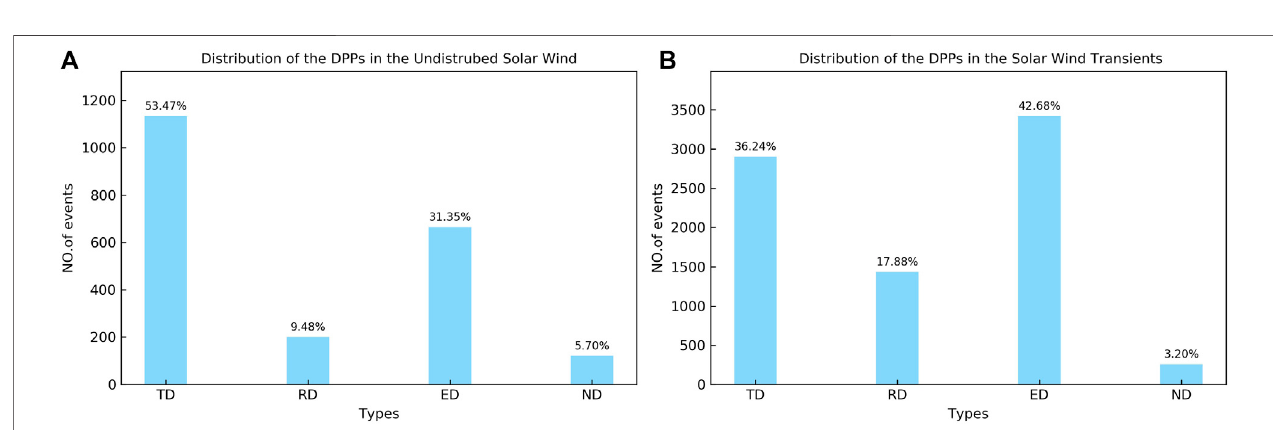
FIGURE11| Component ofDPPeventsintwodifferenttypes ofsolarwind fl ows: (A) intheundistributed solarwind; (B) inthesolarwindtransients.Thefractionof each component of DPP events is marked above the bars.